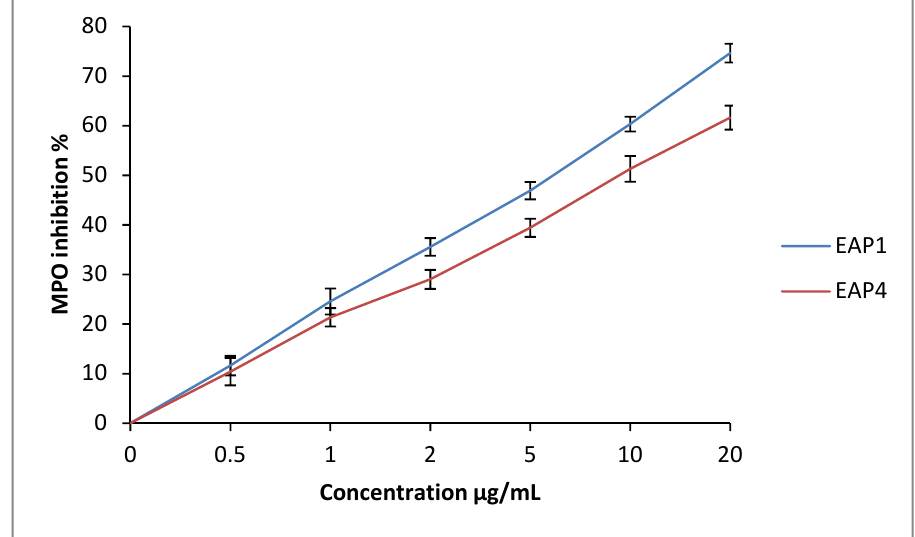
Figure 4. Percentage of inhibition of the MPO activity by ethylacetate extracts of propolis from Tigzirt (EAP1) and yennarou